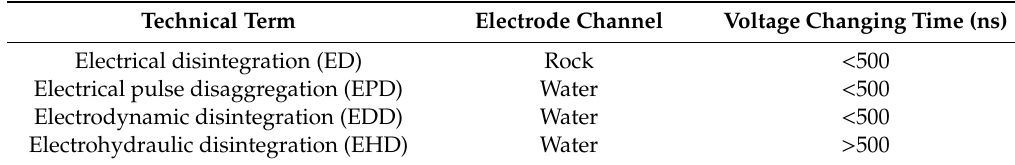
Table 8. Technical terms used for the electrical pretreatment